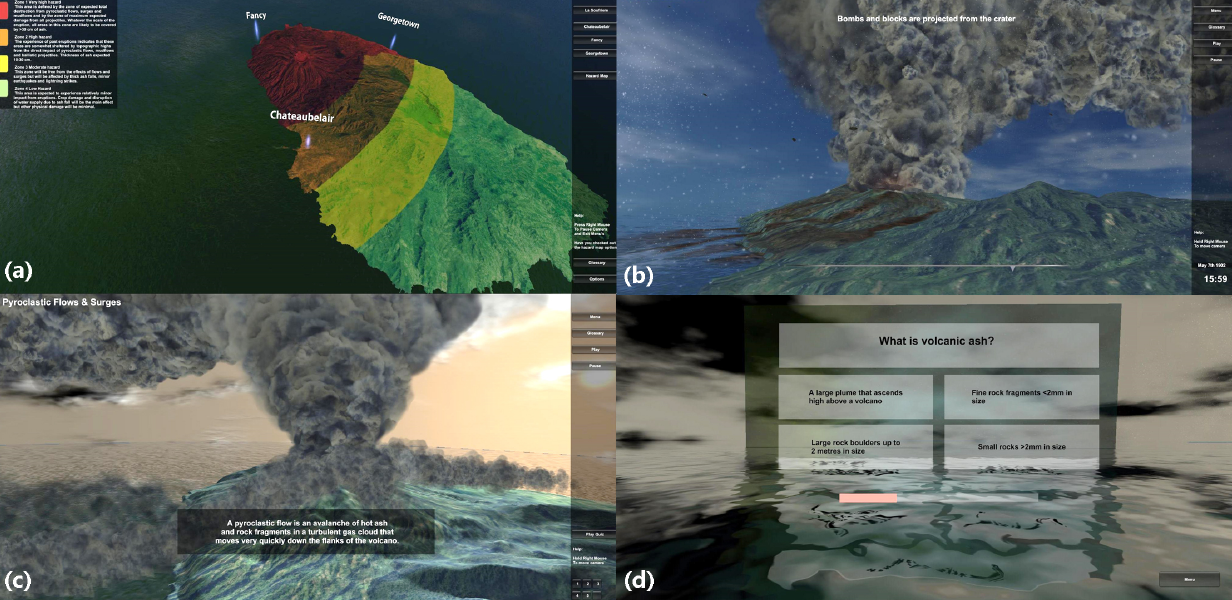
Figure 1. Screenshots from the St. Vincent’s Volcano game. (a) The interactive island model where players can see where they live in proximity to La Soufrière and also view the volcanic hazard map. (b) A scene from the 1902 historical eruption visualisation including textural descriptions of the events as they unfold. (c) Hazard training section of the game for pyroclastic flows and surges with textural descriptions revealed when icons are clicked. (d) An example of a question provided during the volcano quiz at the end of the